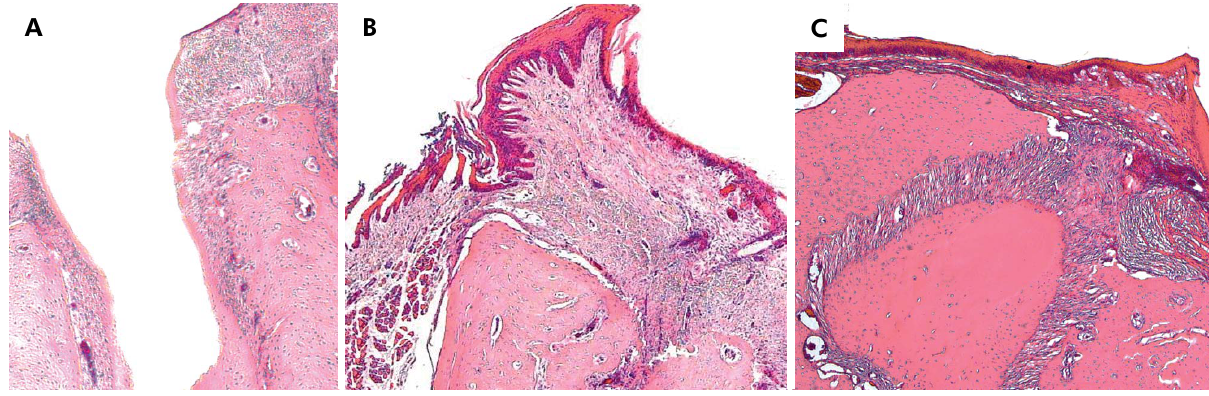
Figure 2. Histologic findings of tooth socket after eight weeks. A: Impaired healing of the epithelium and bone exposure in extraction sockets in the control group. Almost completely healed epithelium in the extraction socket and normal bone remodeling were observed in experimental group 1 (B) and experimental group 2 (C). Hematoxylin-eosin stain,